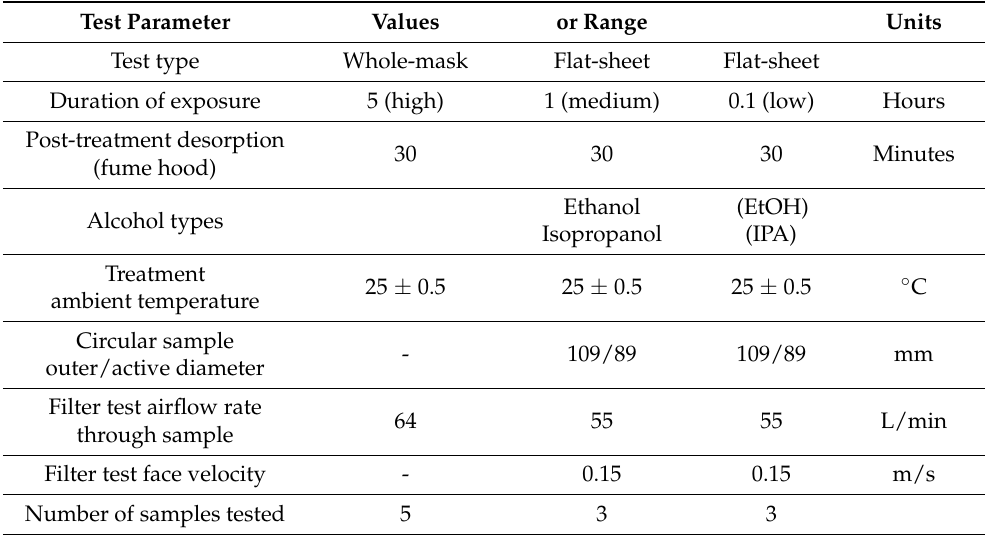
Table 4. Saturated alcohol vapor treatment and test